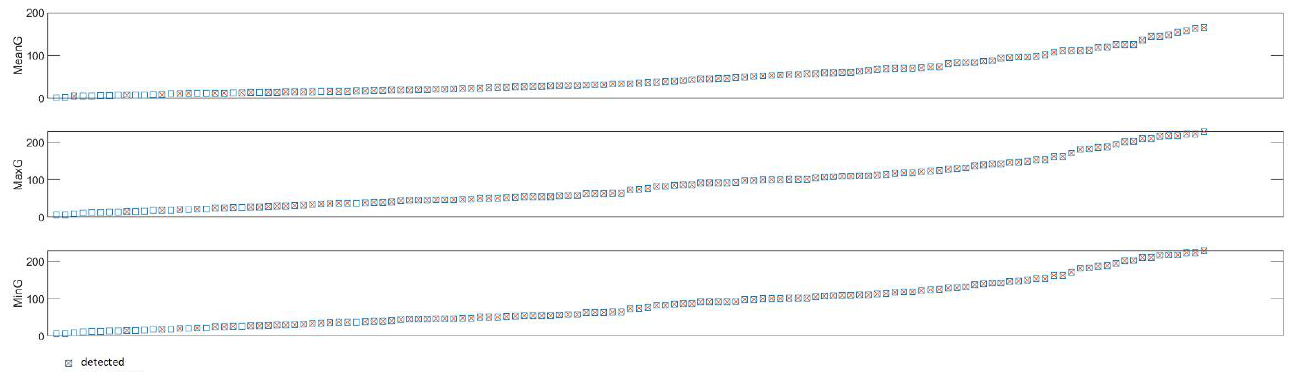
Figure 12. Analysis of the F-points’ detection ability, depending on the spectral response for green.